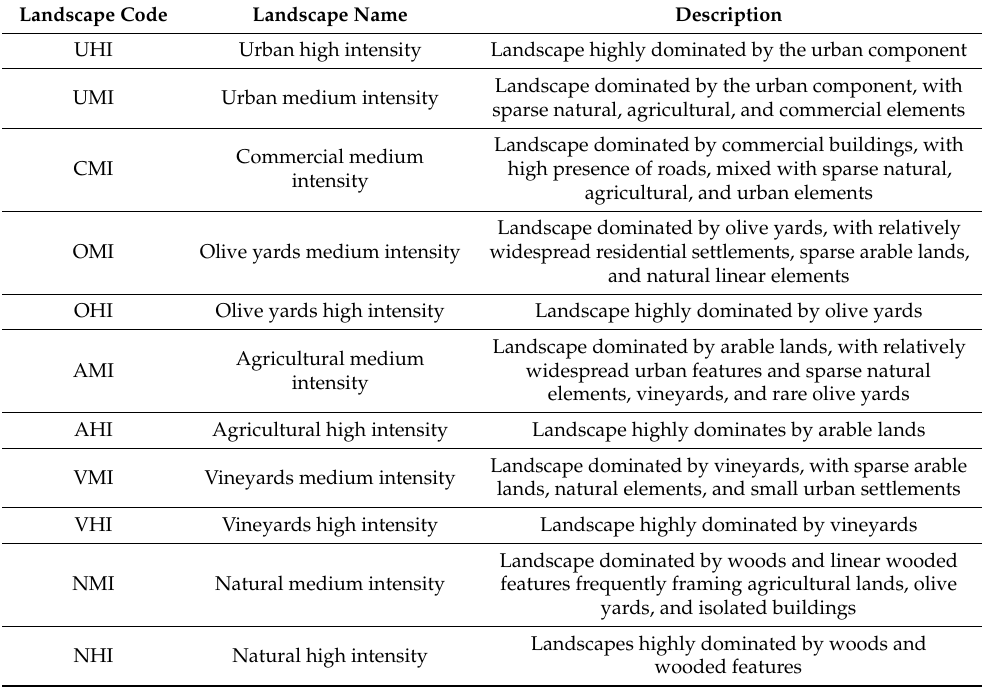
Table 1. Landscape codes, names, and descriptions (extracted from Vizzari et al.